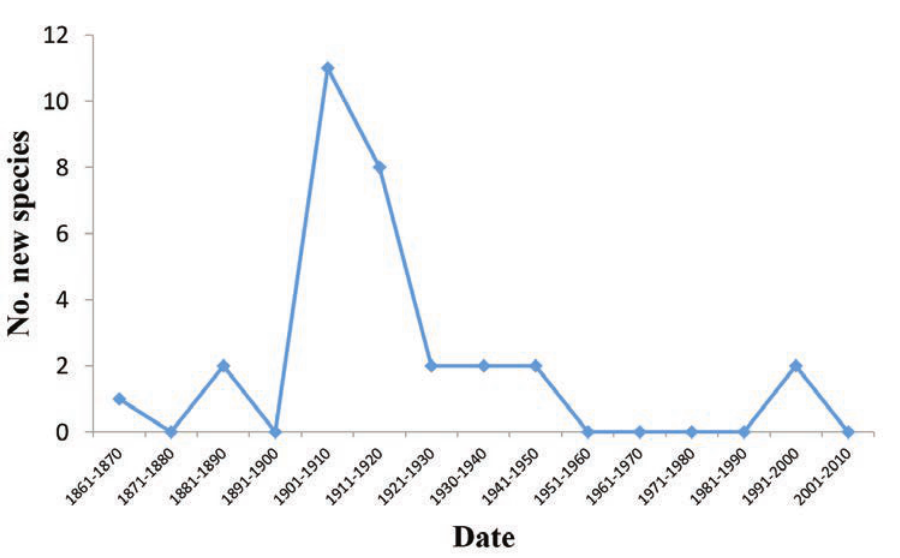
Figure 2. Numbers by decade of new species of Melophorus appearing in the taxonomic literature since 1865 (when Melophorus aeneovirens was